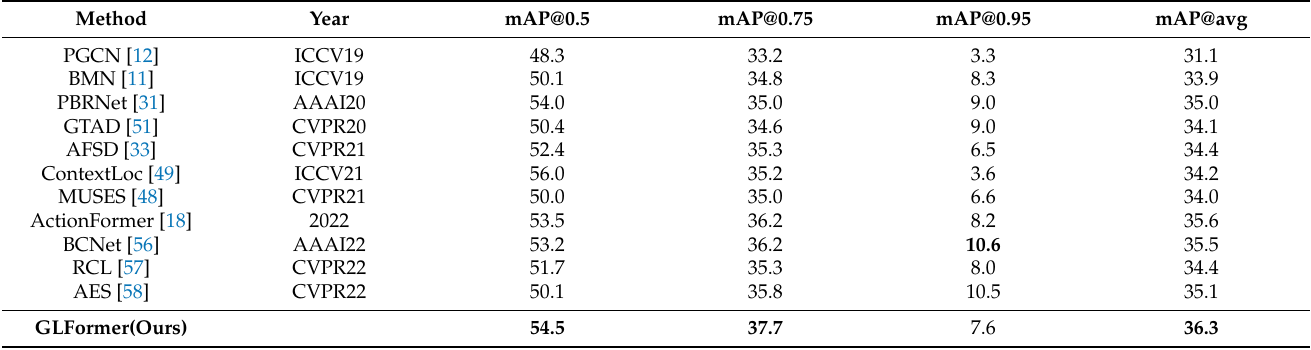
Table 3. Comparison with the state-of-the-art (ActivityNet 1.3), measured by the mAP at different tIoU thresholds, as well as the average mAP in [0.5:0.1:0.95]; the best results are in